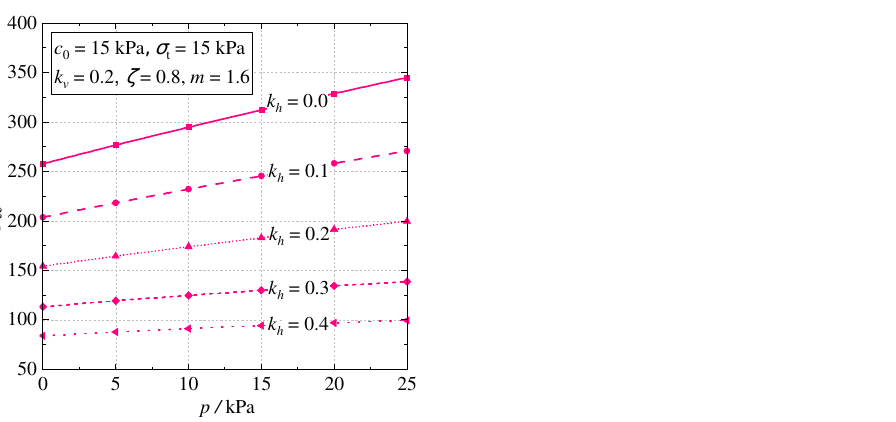
Figure 10. Critical failure surfaces for different p , 0 c , m , and